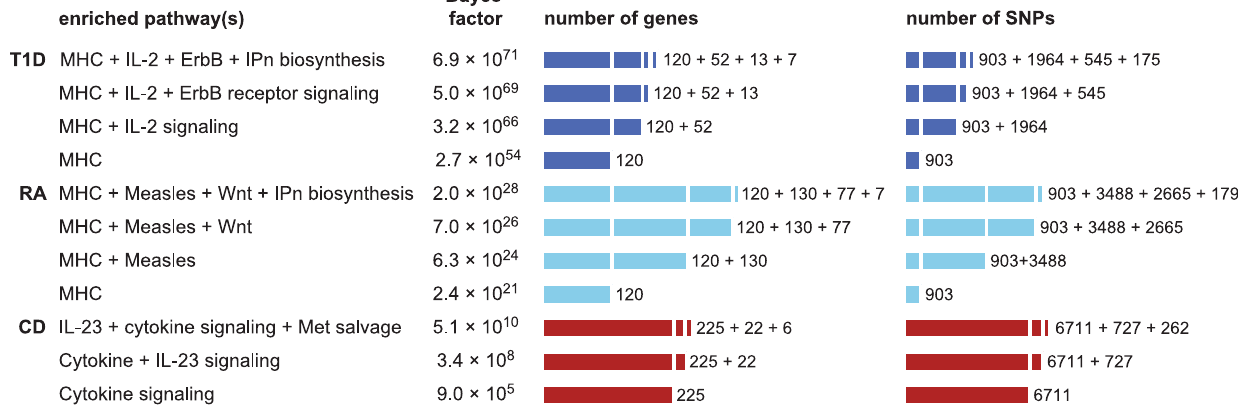
Figure 5. Enrichment hypotheses with multiple enriched pathways show increased support from data. Each row gives pathway, or combination of 2 or 3 pathways, with largest BF for enrichment of disease associations. See Figure 1 for legend and abbreviations used. All enrichment hypotheses for RA and T1D shown here also include enrichment of the MHC, allowing for a different level of enrichment within the MHC. Unlike the BFs in Figures 1 and 2, BFs here are all defined relative to null hypothesis of no enrichment, so that they can be easily compared. Counts of genes and SNPs only include those that are not already assigned to other enriched pathways; for example, 37 genes belong to the IL-23 pathway, and of those 15 are already cytokine signaling genes, so inclusion of IL-23 signaling adds 22 more genes. Databases and database identifiers for pathways in this figure: ‘‘IL2-mediated signaling events’’ (PID il2_1pathway, BS 137976); ‘‘ErbB receptor signaling network’’ (PID erbb_network_pathway, BS 138016); ‘‘Inositol pyrophosphates biosynthesis’’ (HumanCyc 6369, PC); ‘‘Measles’’ (KEGG hsa05162, BS 213306); ‘‘Wnt’’ (Cancer Cell Map, PC); ‘‘Cytokine signaling in immune system’’ (Reactome 75790, BS 366171); ‘‘IL23-mediated signaling events’’ (PID il23pathway, BS 138000); ‘‘Methionine salvage pathway’’ (Reactome 75881, BS 366245).